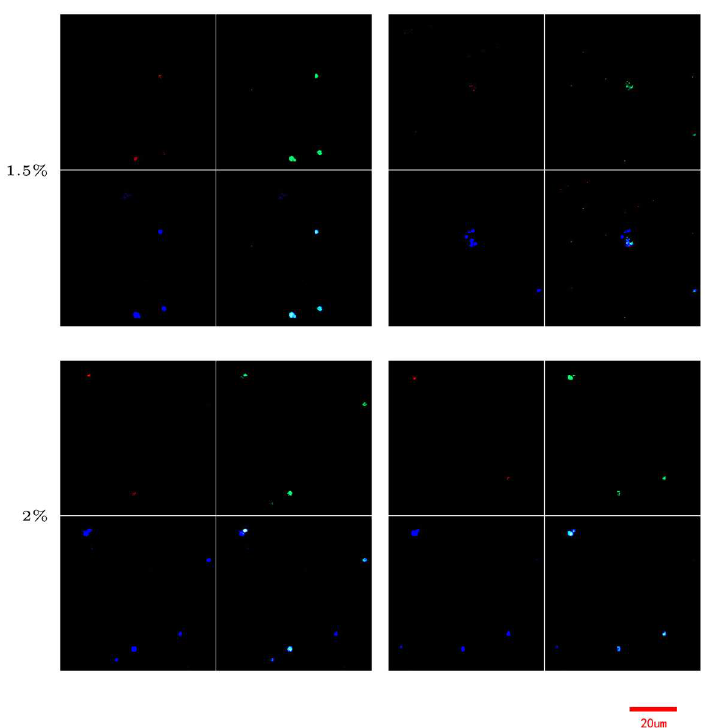
Figure 5. Immunofluorescence of live/dead cells in SCL and Ca 2+ hydrogels. 0.8%, 1.1%, 1.5%, and 2% are the concentrations of alginate in both types of hydrogels, and the varying concentrations of alginate present for the different groups of hydrogels.